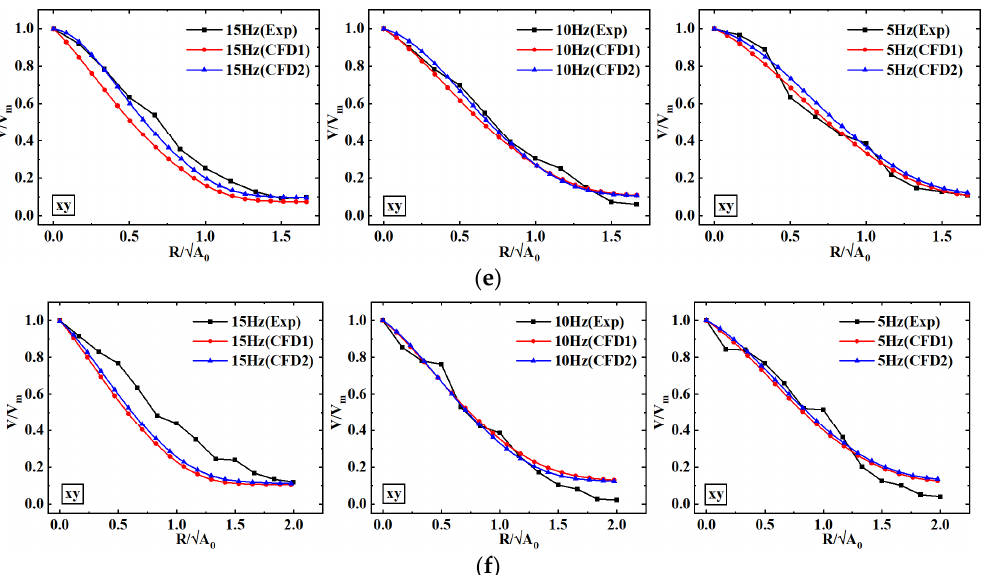
Energies 2023 , 16 , x FOR PEER REVIEW 13 of 17